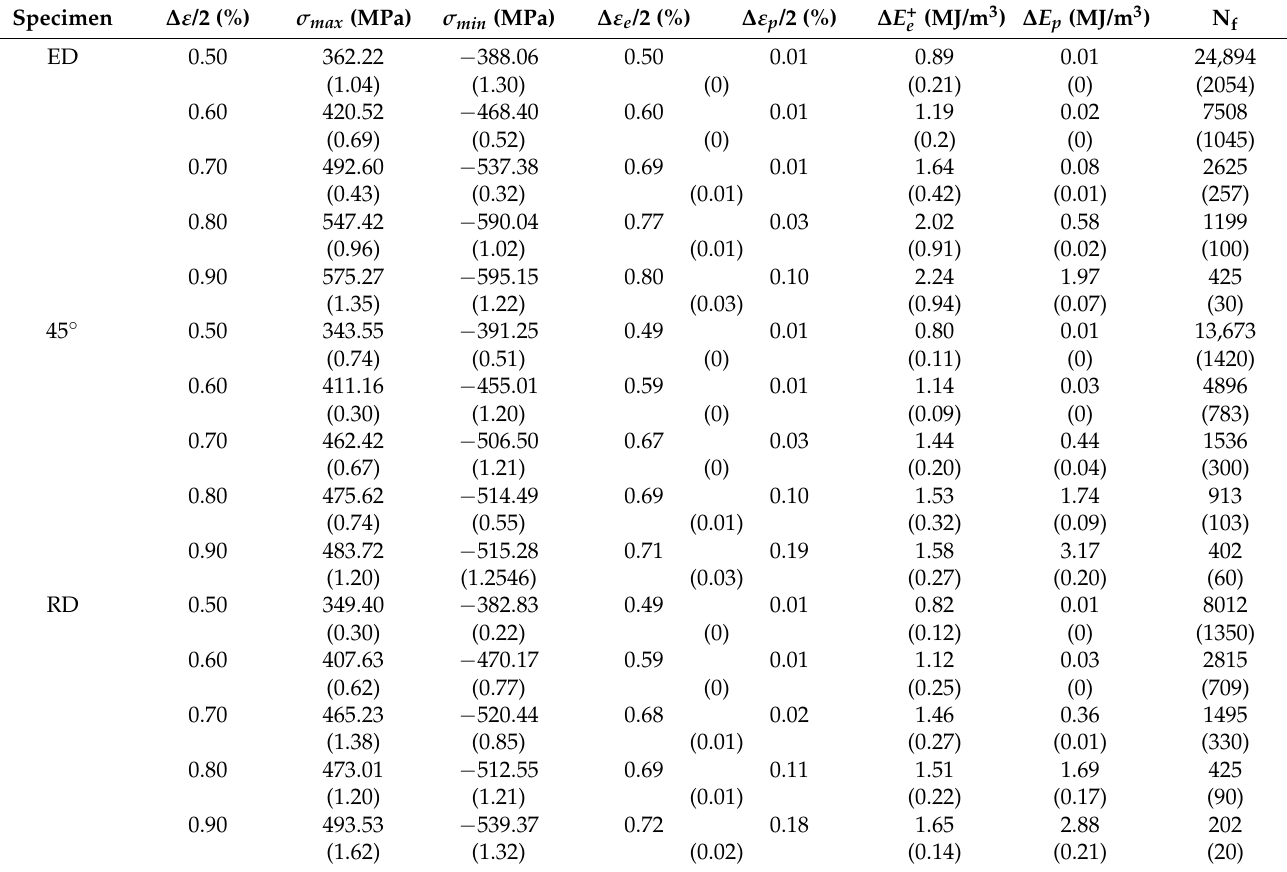
Table 3. Fatigue tests summary for the half-life cycle. (The numbers in the parentheses are standard deviations).